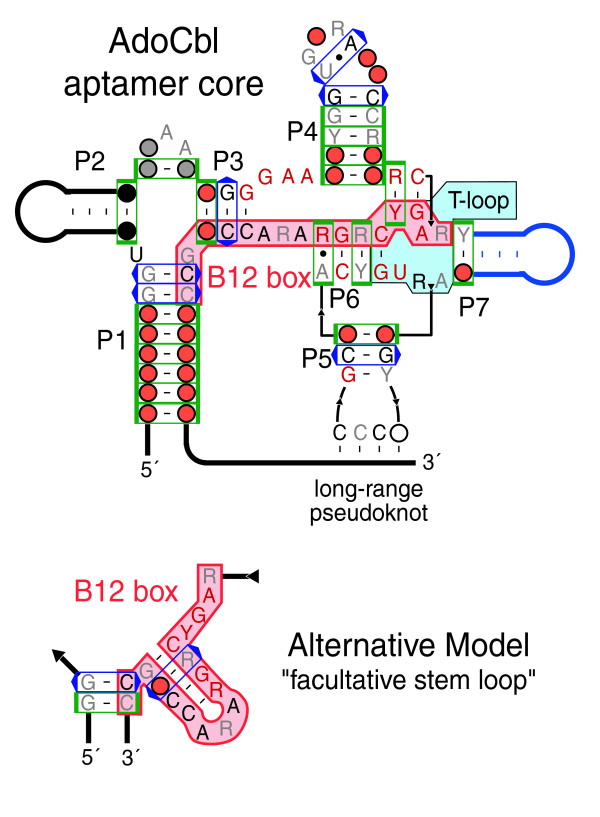
Comparison of B12 box structure models. In addition to the model of the AdoCbl riboswitch aptamer structure presented here [39], an alternative model that folds the highly conserved B12 box sequence (highlighted in red) into a 'facultative stem-loop' has been proposed [20]. The core of the AdoCbl riboswitch aptamer is shown with abbreviated peripheral helices and without the optional P8-P10-P11 domain for comparison with the alternative secondary structure model. The upper model is supported by multiple base pairs with significant MI scores between B12 box bases and remote positions. In it, a portion of the B12 box also forms part of an internal T-loop motif between P6 and P7. Each diagram uses the symbols described in the legend to Figure 5.